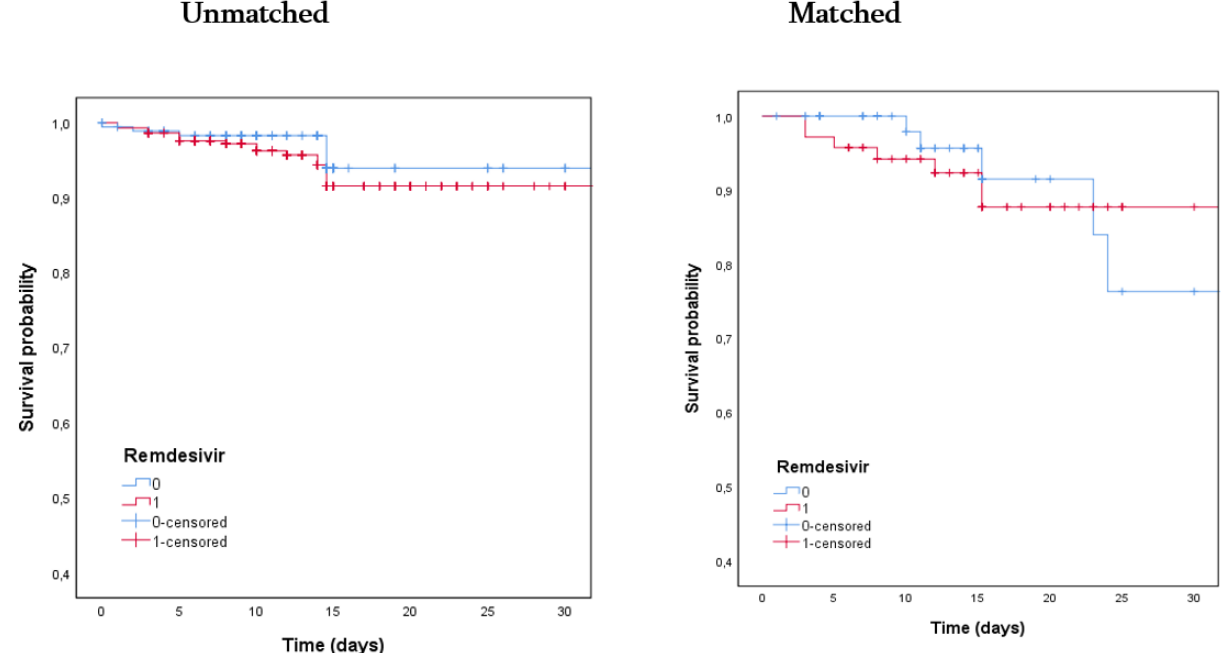
Table 4. Multivariate Cox regression analysis of 30-day mortality after propensity score matching.